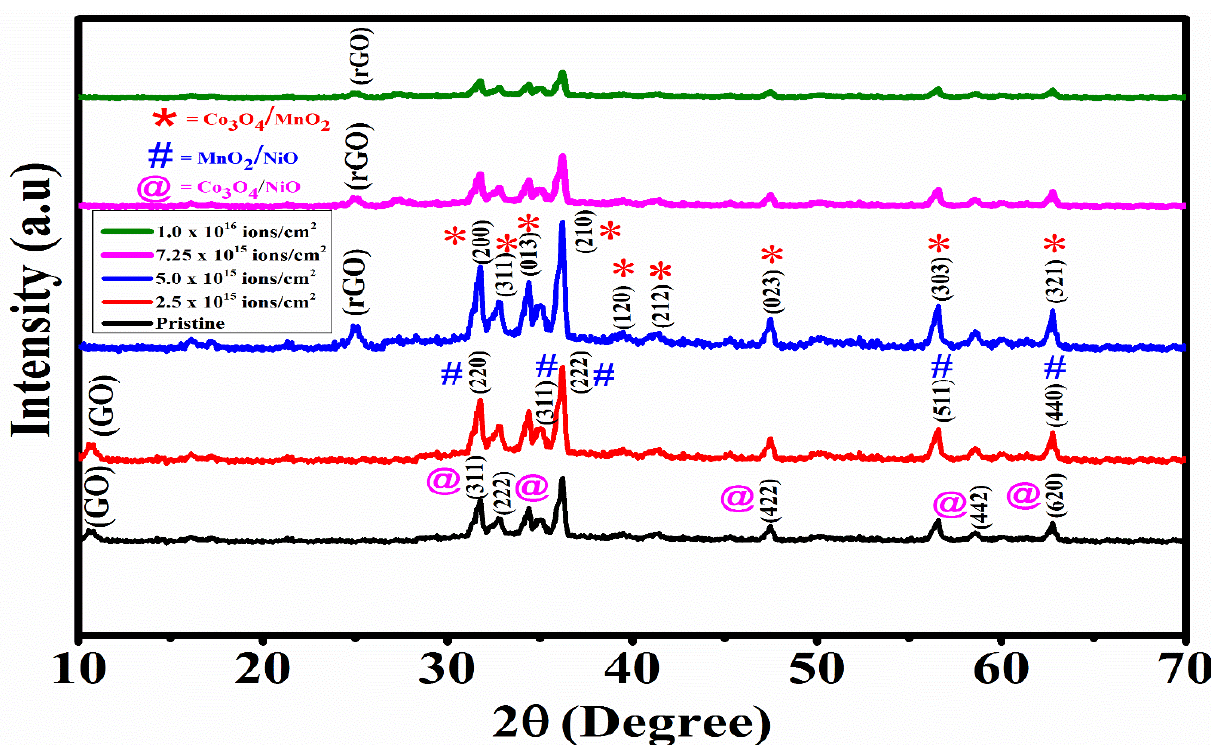
Figure 2. (a) XRD spectra of hydrothermally synthesized GO